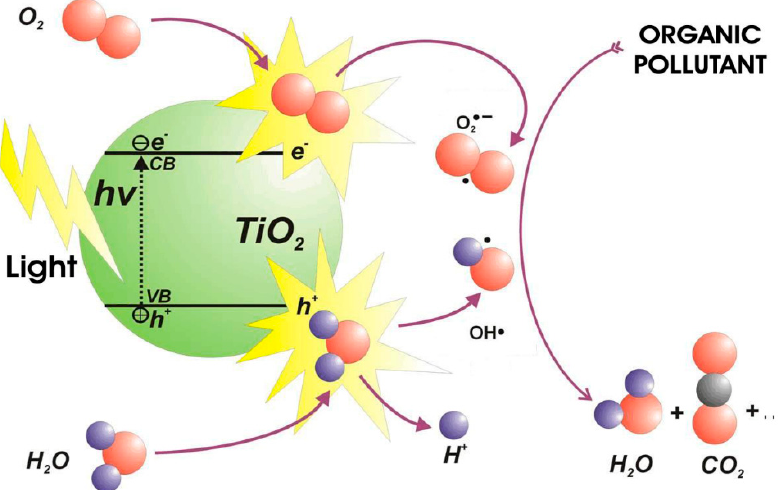
Figure 1. Basic principles of photodegradation process using semiconductors (example: TiO 2 ) [14]. Among the other semiconductors, TiO 2 has become a promising material that has been